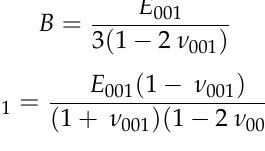
Table 2. Temperature dependence of elastic stiffnesses 𝑐 (cid:3036)(cid:3037) of CMSX-4, GPa. T , °C